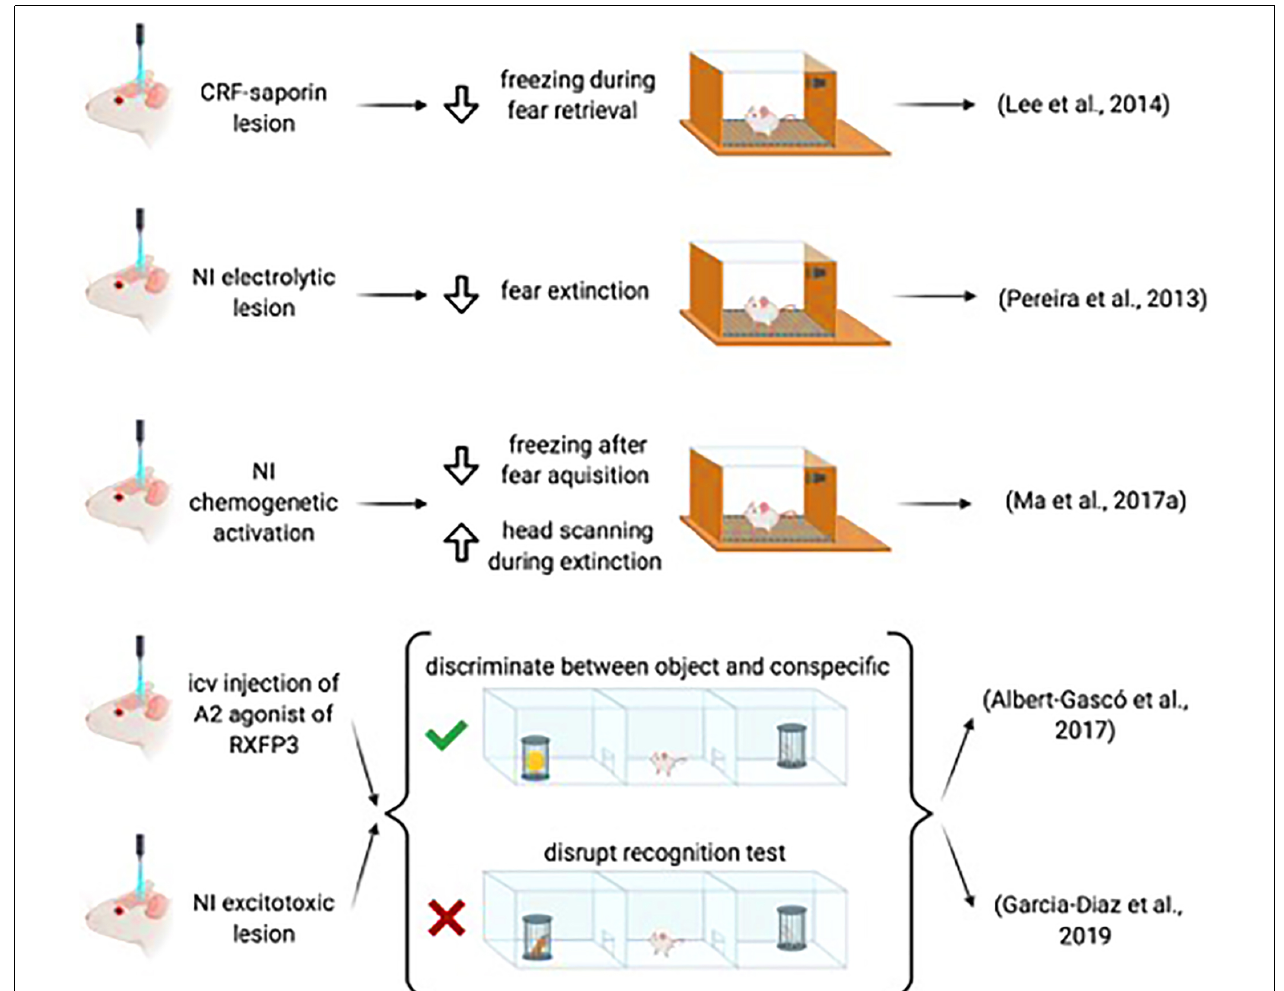
FIGURE 4 | Summary of the data demonstrating the involvement of the NI-RLN3-RXFP3 system in social and emotional memory.